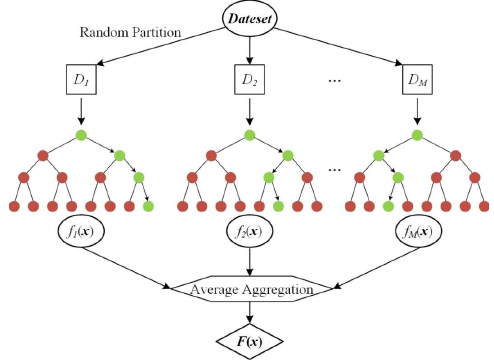
Figure 1. Algorithm diagram of RF regression.